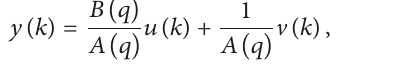
Figure 1: Sensor location for experimental setup. The dashed breakout view is rotated 90 ∘ and depicts the six sensors for capturing the dynamics of the blade